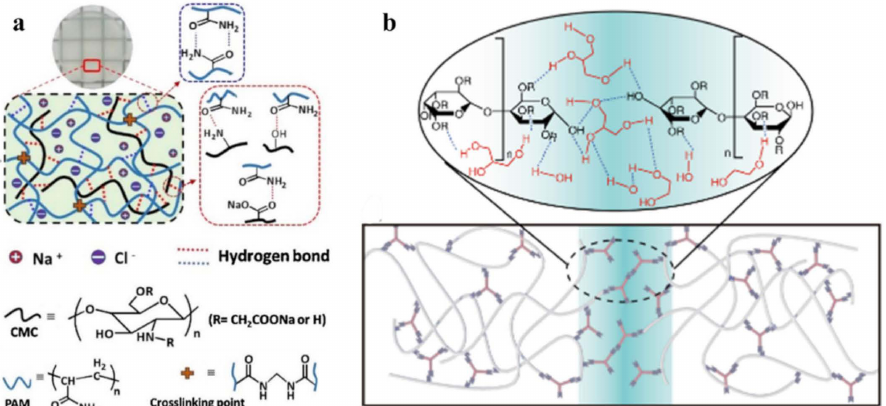
Figure 15. ( a ) Composite hydrogels schematic. Reproduced from [144] with permission from Elsevier. ( b ) Schematic diagrams of the self-healing properties of an elastomeric gel. The gray lines represent hydroxyethylcellulose polymer chains and form cross-linked networks. The purple shapes on polymer chains and brown short lines form primary H-bonds between polymer chains and glycerol. Reproduced from [145].